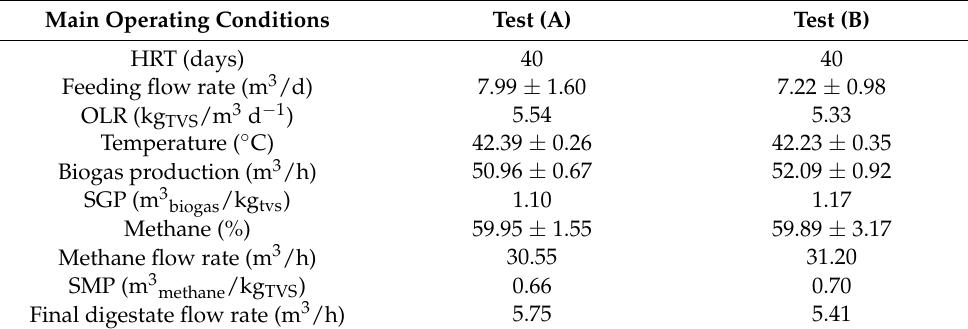
Table 1. Main operating conditions and performances of the full-scale anaerobic digestion plant-to- energy plant.